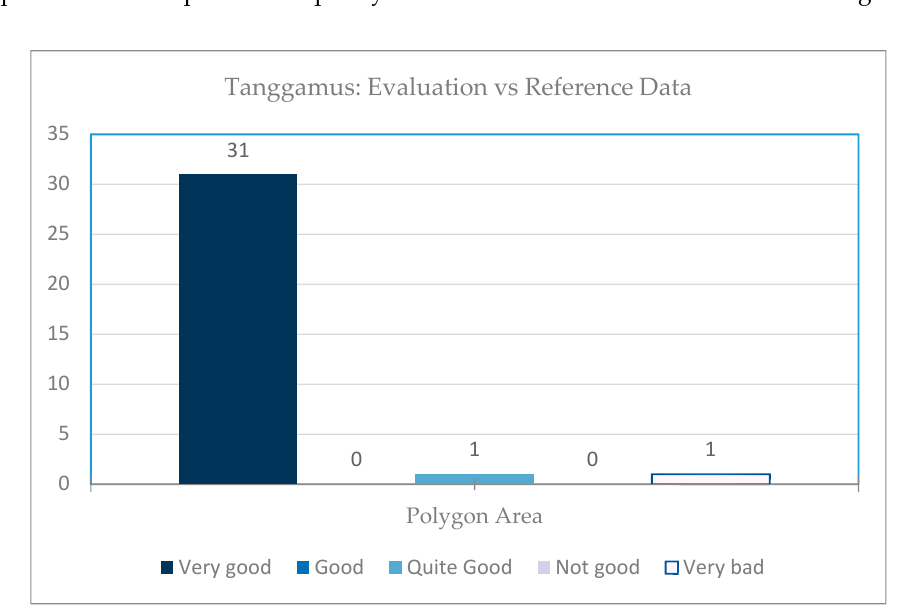
Figure 4. Visualization of differences in the results of evaluation (blue) and reference (black) polygonal data in the study area of Tanggamus pilot .